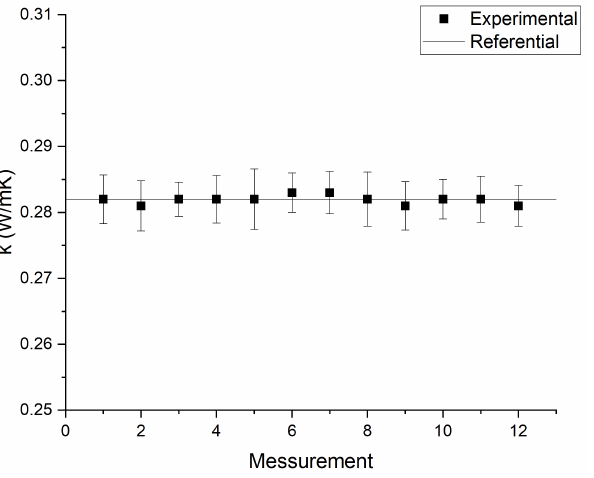
Figure 4. Traceability test results of KD2-Pro measurements. The error bars correspond to the KD2-Pro measurement